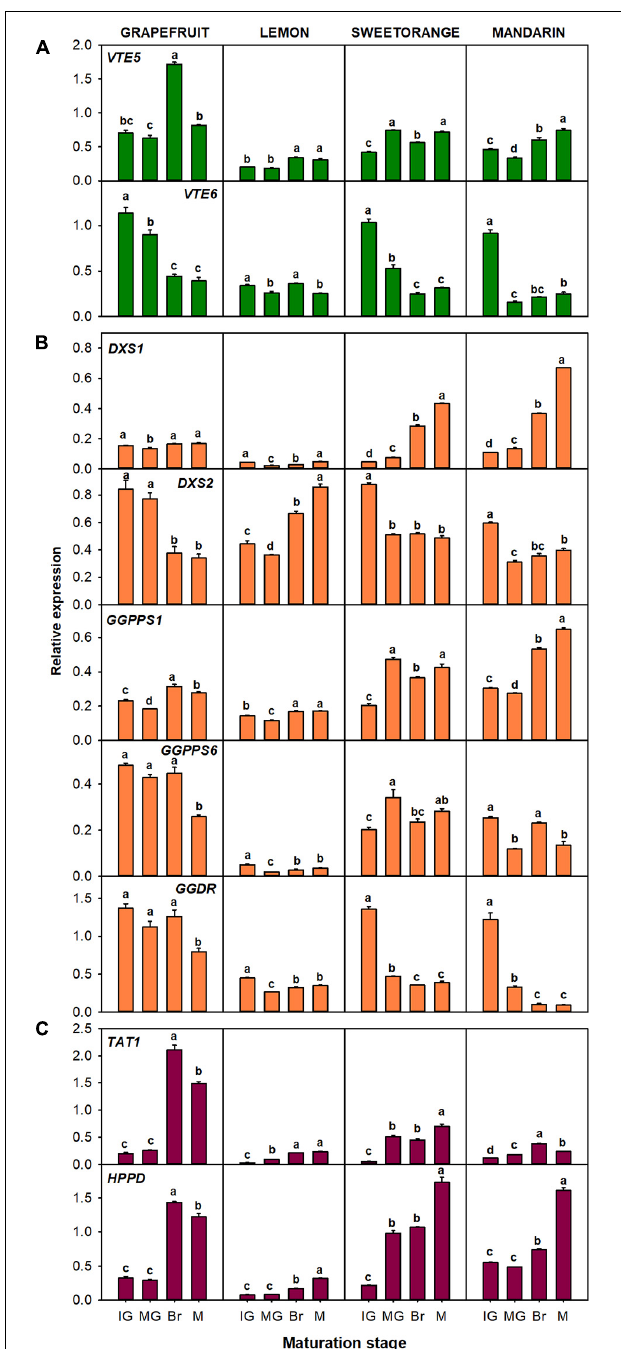
FIGURE 6 | Relative expression of genes involved in the synthesis of precursor PPP (phytyl pyrophosphate), through the recycling of free phytol (A) and MEP pathway (B) , and of precursor HGA (homogentisate) through the SK pathway (C) , in the pulp during fruit maturation of grapefruit ( C. paradisi ), lemon ( C. limon ), sweet orange ( C. sinensis ), and mandarin ( C. clementine ). The genes analyzed were VTE5 (phytol kinase), VTE6 (phytyl-P kinase), DXS1 and DXS2 (1-deoxy- D -xylulose-5-phosphate synthase 1 and 2), GGPPS1 and GGPPS6 (geranylgeranyl pyrophosphate synthase 1 and 6), GGDR (geranylgeranyl diphosphate reductase), TAT1 (tyrosine aminotransferase), and